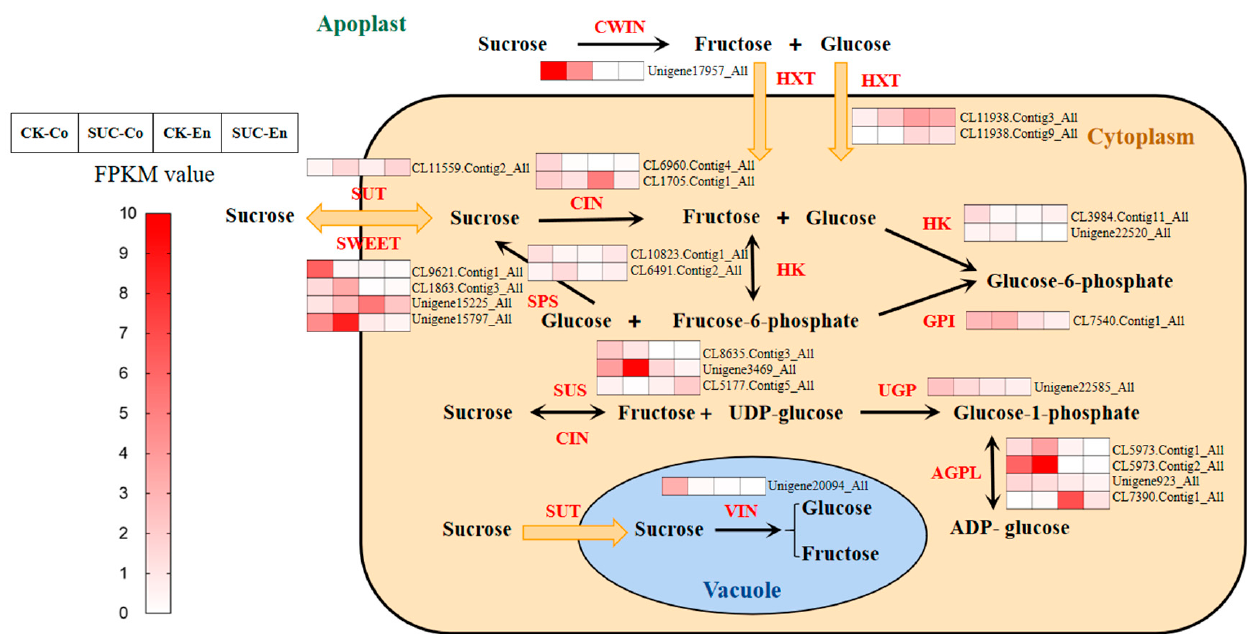
Figure 5. Heat maps of the expression genes involved sucrose metabolism and transporter pathway during the development of P. ostii seed at 50 days after flowering with and without sucrose treatment. SUT, sucrose transporter; SWEET, sweet sugar transporter; HXT, hexose transporter; SUS, sucrose synthase; SPS, sucrose phosphate synthase; CWIN, cell wall invertase; CIN, chloroplast invertase; VIN, vacuolar invertase; HK, hexokinase; GPI, glucose-6-phosphate isomerase; UGP, UTP-glucose- 1-phosphate uridylyltransferase; AGPL, glucose-1-phosphate adenylyltransferase. The red from light to dark represents the expression level from low to high. CK-Co, seed coat as the control; SUC-Co, seed coat with sucrose treatment; CK-En, endosperm as the control; SUC-En, endosperm with sucrose